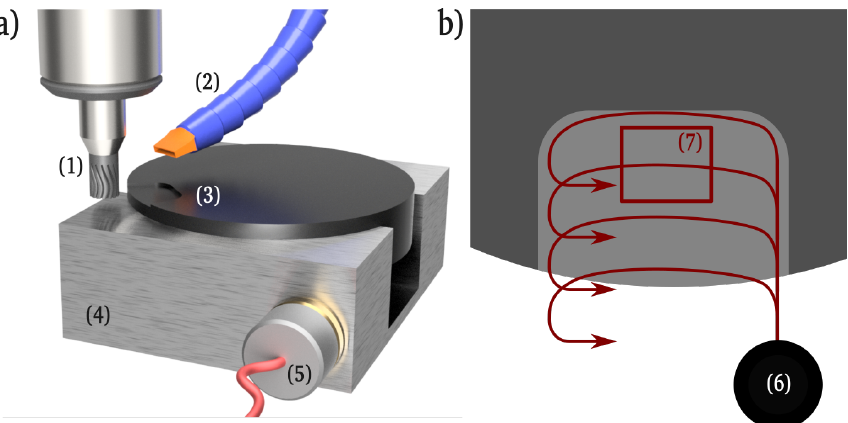
Figure 2. The experimental setup ( a ) showing the tool with toolholder (1), the coolant supply nozzle (2), sample specimen (3) held in soft jaws from steel (4), with the magnetic acoustic emission sensor (5) ( b ) the toolpath kinematics (6) showing the measured region of interest (7).